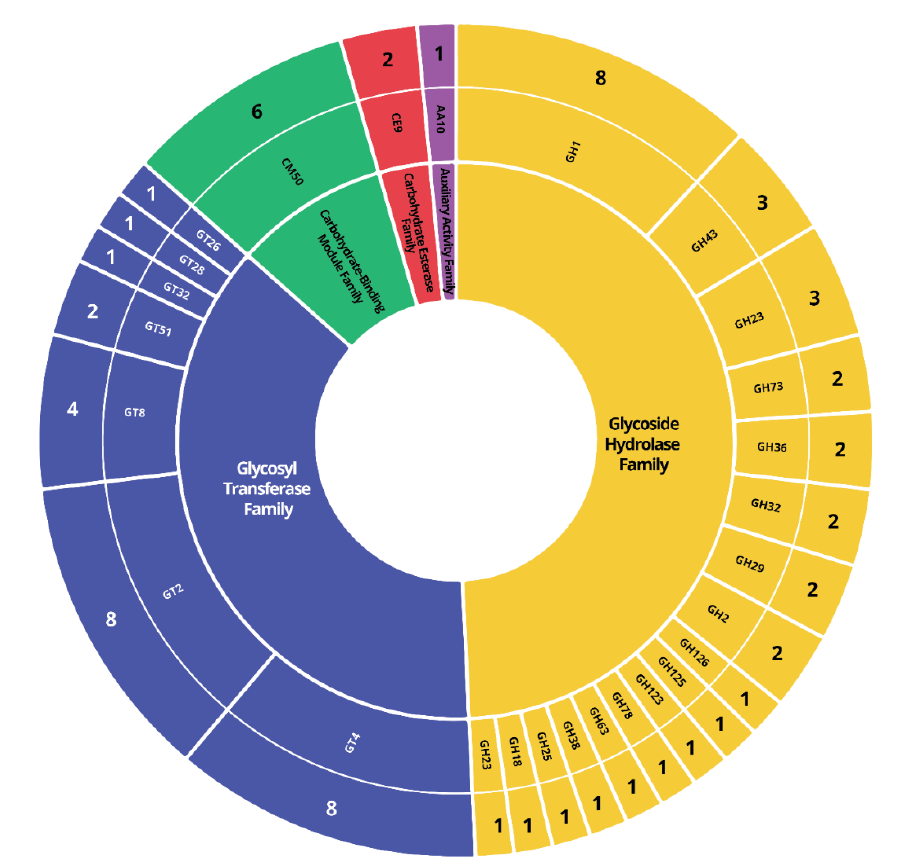
Figure 7. CAZymes distribution in HN9 genome. CAZymes were assigned by searching against the CAZy database using the dbCAN webserver. Different colors represent different classes of CAZymes found in the genome. The representation from the inner to outer rings are, CAZyme classes, CAZyme families, and the number of genes identified in each family, respectively.